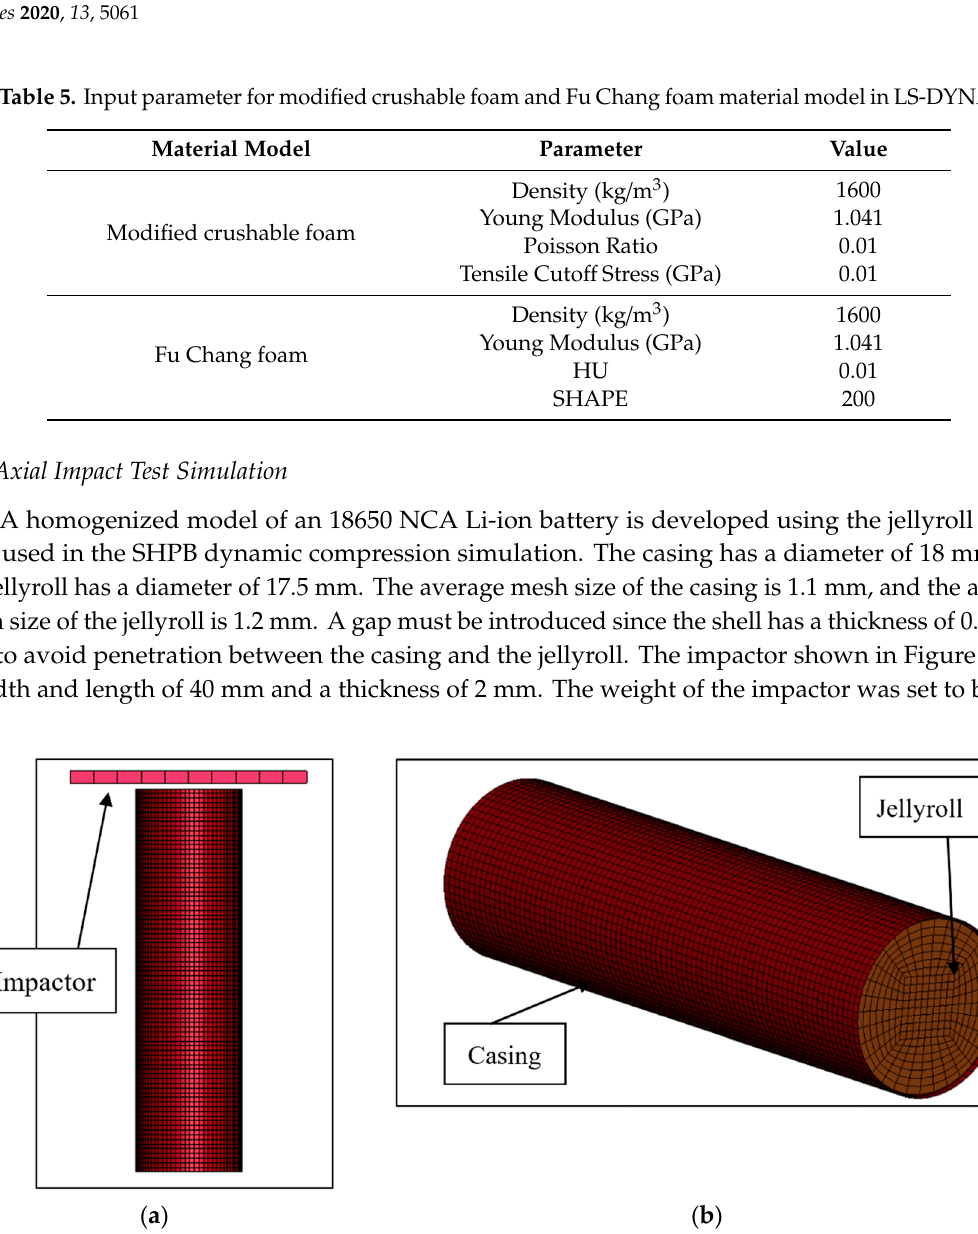
Figure 10. ( a ) Side view of the setup for the axial impact simulation of the battery. ( b ) Isometric view of the battery showing the casing and the jellyroll arrangement. of the battery showing the casing and the jellyroll